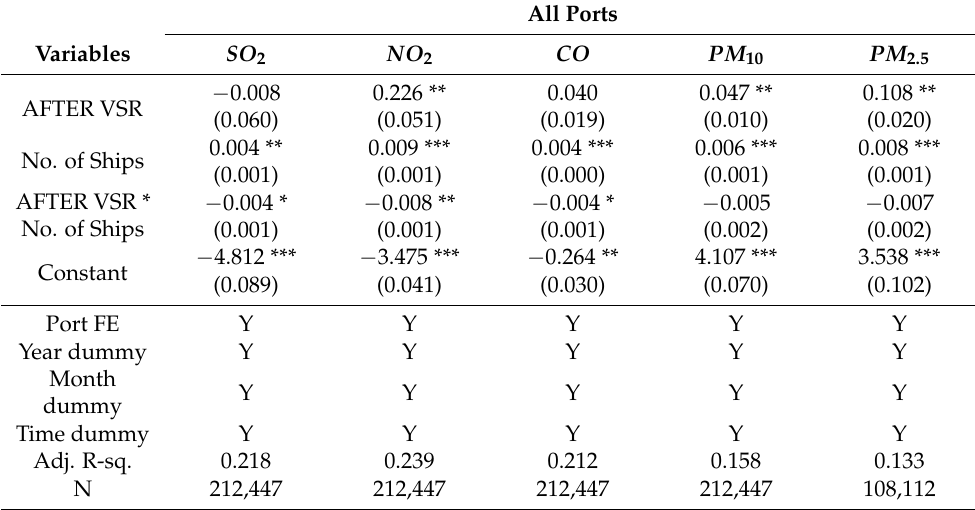
Table 3. Estimation results of panel regression for the big three